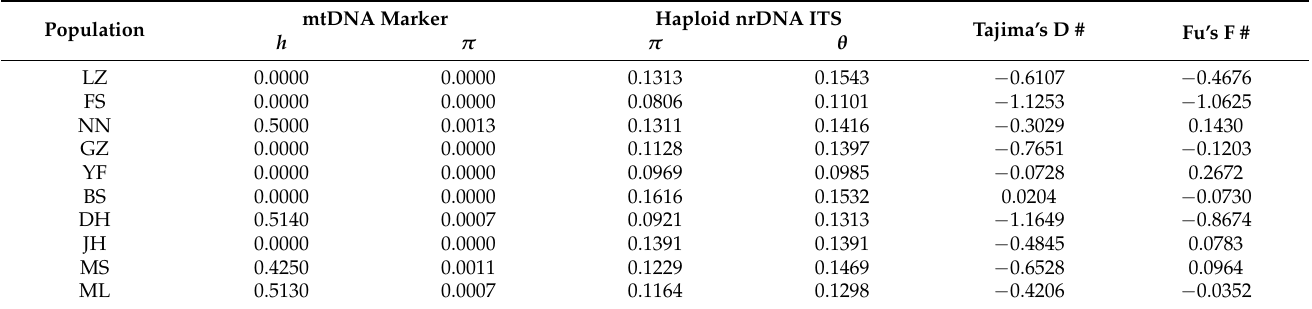
Figure 2. A network of mitochondrial haplotypes from the concatenated sequences of primers F1-R1 and F2-R2 amplifications. The circle sizes are proportional to the haplotype frequencies among 161 samples. The number of haplotypes is provided within each circle. Base substitutions between haplotypes are shown on the double-head arrows and the number of 318 or 647 on the double-head arrows refers to the position for base substitutions in the aligned sequences. Table 2. Genetic diversity of mtDNA and nrDNA ITS markers and the neutrality tests of the haploid nrDNA ITS sequences in ten populations of N. cadamba.